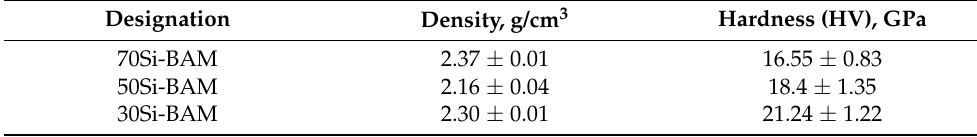
Table 5. Properties of the sintered specimens.